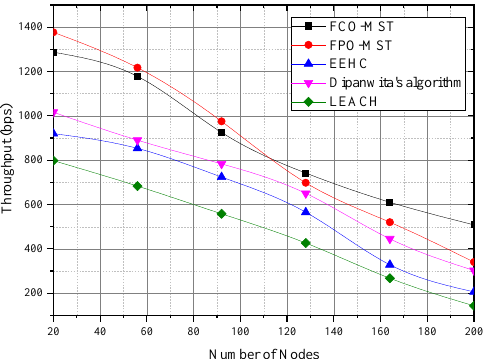
Figure 14. The comparison of throughput under a different number of nodes.